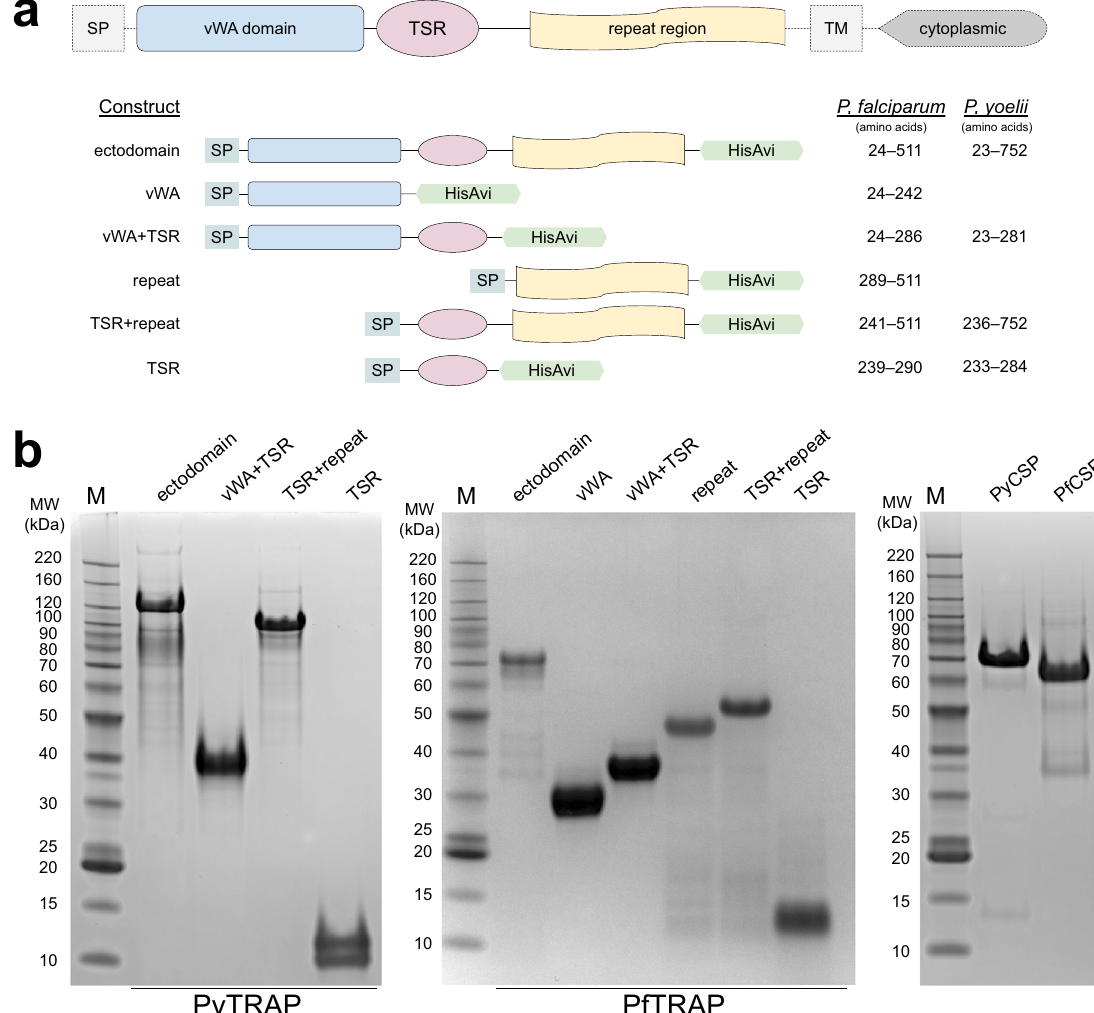
Fig. 1 TRAP domain organization and constructs used. Ectodomain and deletion constructs for PyTRAP and PfTRAP generated using the domain boundaries ( a ) were recombinantly expressed and puri fi ed alongside the control CSP ectodomain proteins ( b ). All gels were processed in parallel. SP signal peptide, TM transmembrane